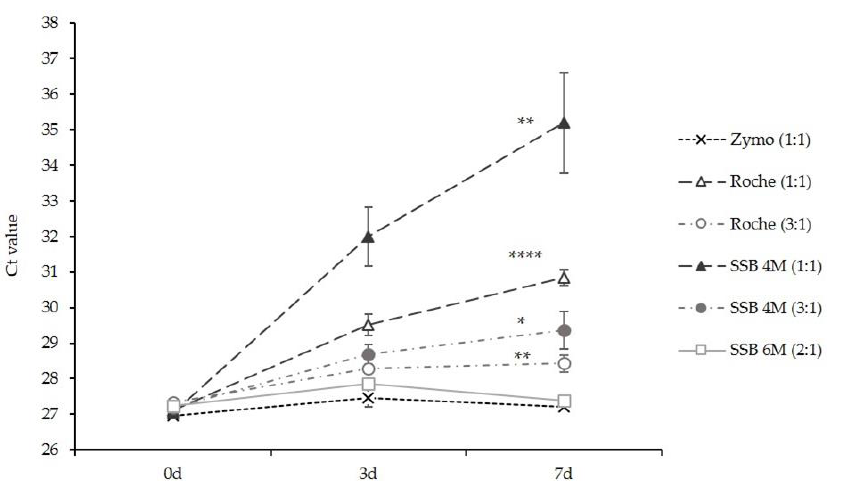
Figure 3. Chaotropic solutions with >4M GuHCl efficiently preserve SARS-CoV-2 RNA stability in pharyngeal lavage. Pharyngeal lavage samples of healthy individuals were diluted in different sam-